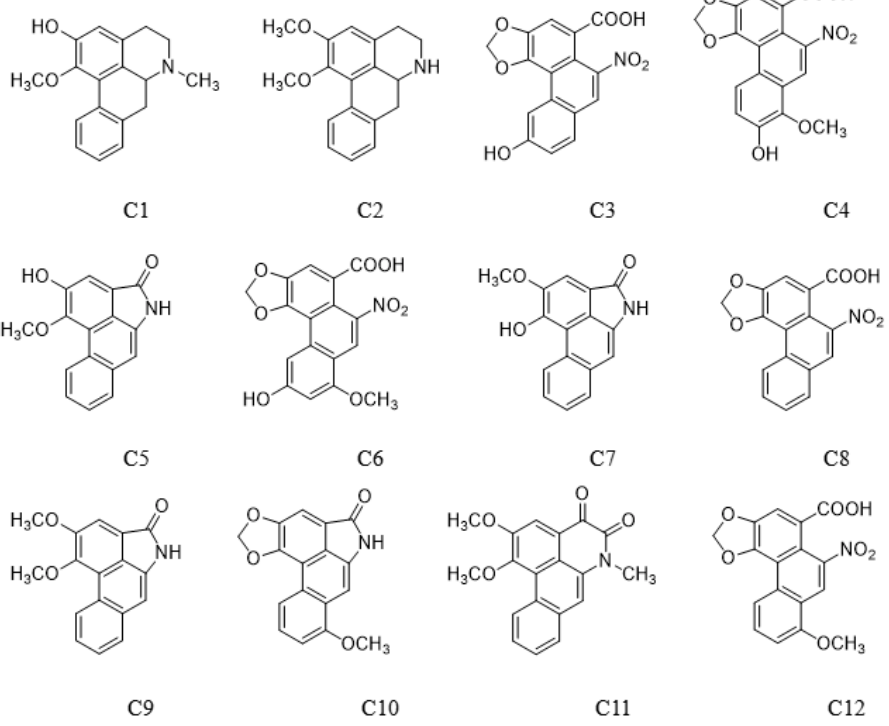
Figure 5. Chemical structures of 12 compounds.